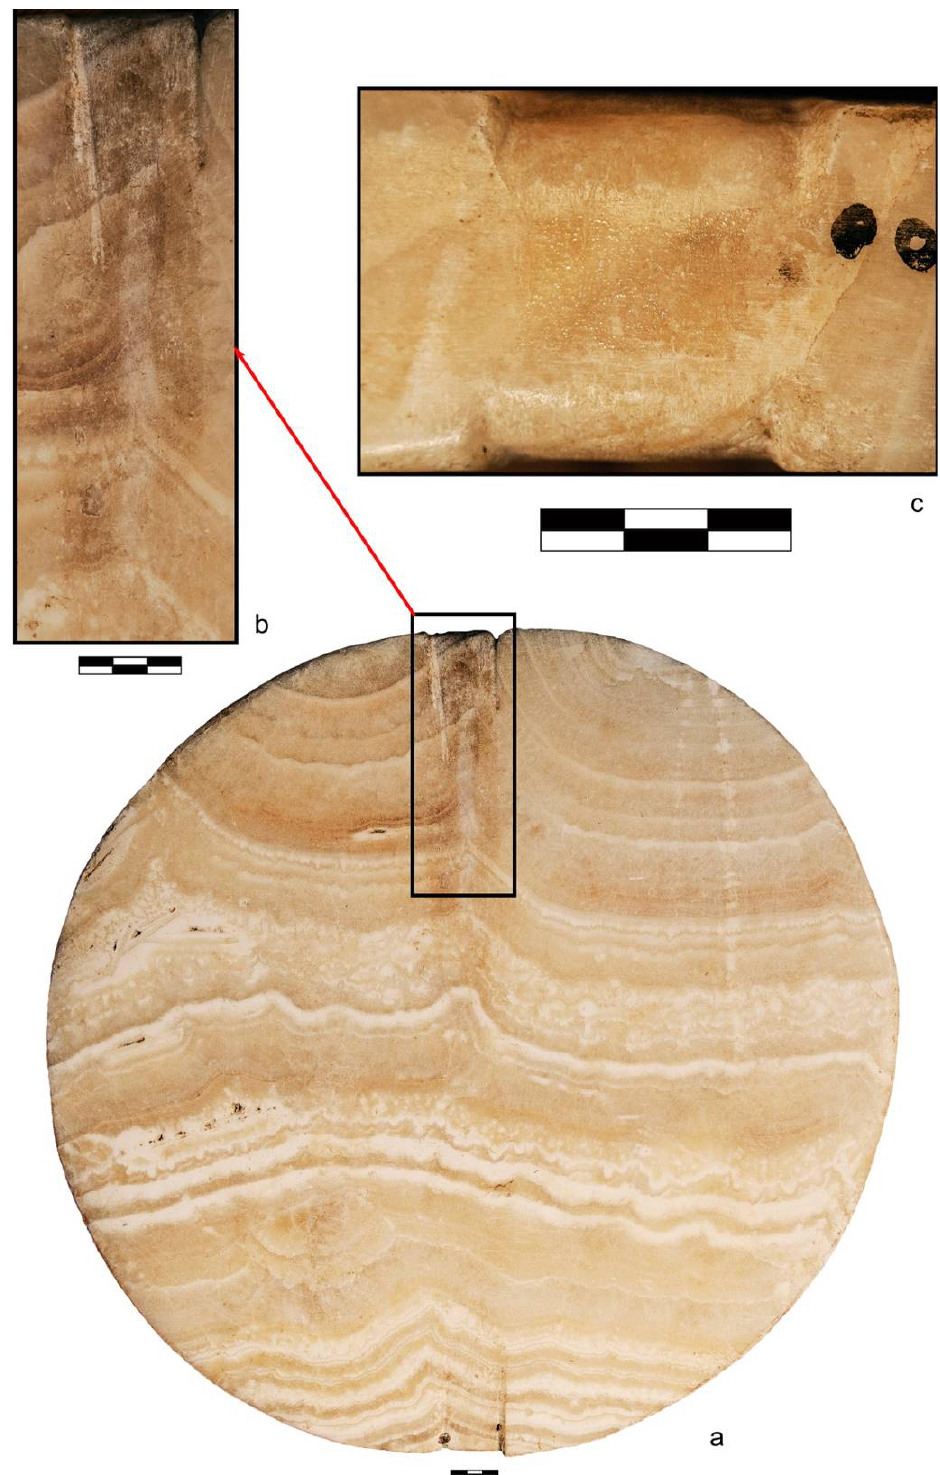
Figure 23. Stone disc from Gonur Depe (from the depositories of the National Museum of Turkmenistan, Ashgabat): a. photograph of a frontal view of a stone disc with symmetrical grooves at the edges of the circle, connected by a strip made by polishing; organic residues were found on the strip; b. traces of cutting the groove and decayed organic matter in it; c. lateral side of a stone disc with a cut groove, the surface of which has traces of processing by grinding and polishing. Scale bar is 3 cm long, separated into three 1 cm